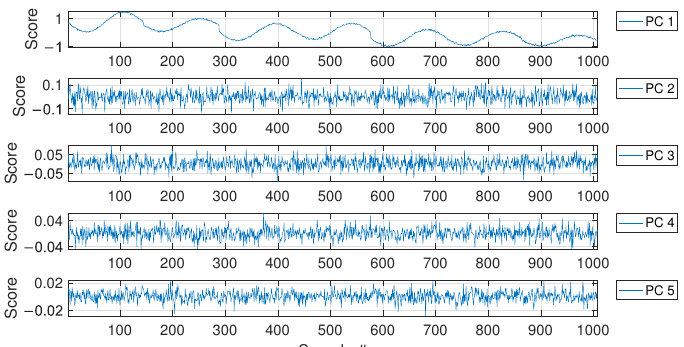
Figure 11. PC scores for the baseline set of eigenfrequencies containing a number b = 1008 of observations, considering both long-term and short-term temperature trends.